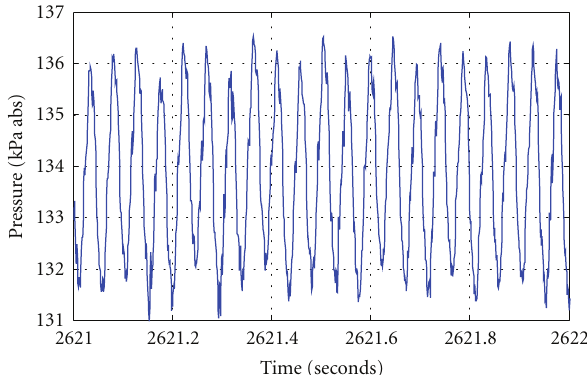
Figure 15: Pressure fluctuations in the exhaust (discharge plenum) prior to audible change at 16,000 rpm.